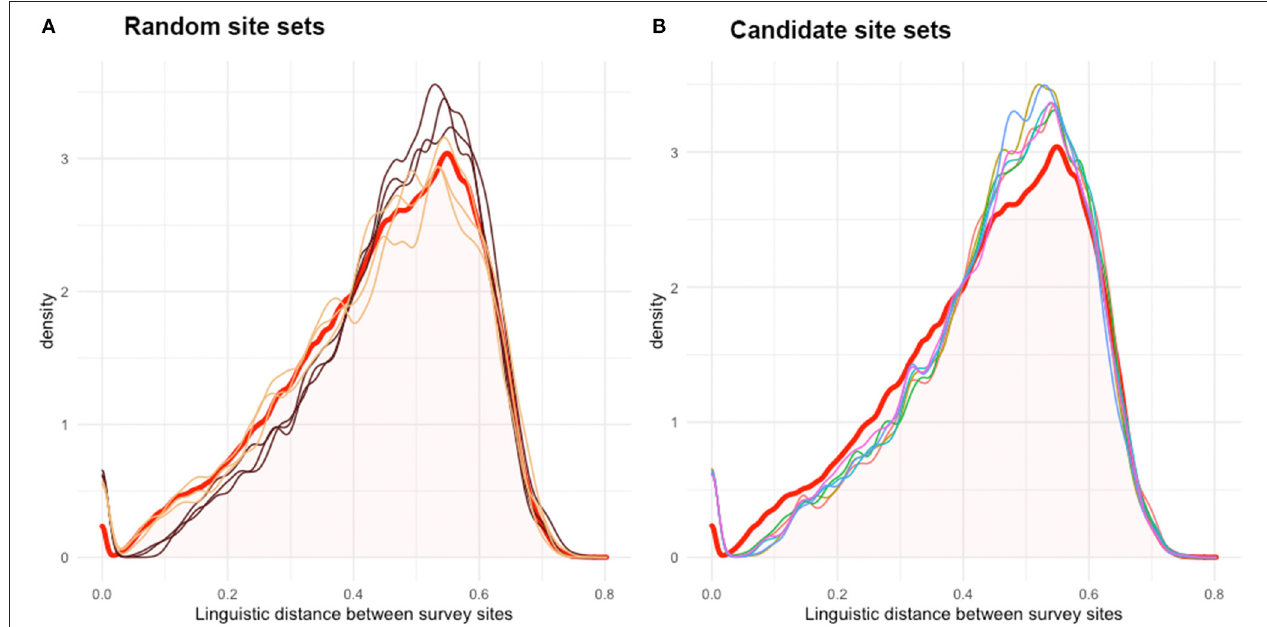
FIGURE 4 | Density graph of the values within linguistic distance matrices. In (A) , the linguistic distance matrices from three unrestricted random sets (yellow) and random sets from the resulting clusters of each clustering method (brown) are plotted together with the original mean linguistic distance matrix ( LD —red). In (B) , linguistic distance matrices from the candidate survey site sets are presented. Beside unrestricted random sets, all sets overshoot the peak density of LD . Thus, on average, linguistic distances are larger within these candidate site sets, as expected, and their members are linguistically more different from one another.